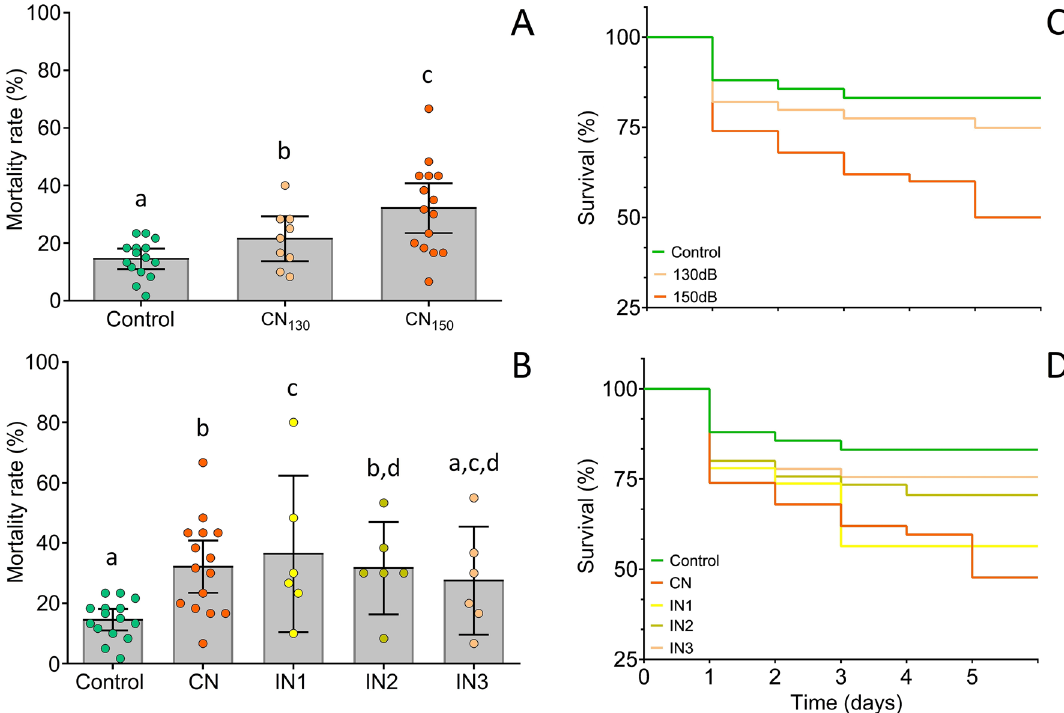
Figure 1. Comparison of mean mortality rate between treatment groups (larval zebrafish up to 5 days post fertilization) exposed to ( A ) continuous noise at different amplitudes (F (2, 38) = 8.71, p < 0.001) and ( B ) varying noise temporal patterns (F (4, 47) = 3.78, p = 0.005). Kaplan–Meier percentual survival plot of zebrafish larvae throughout the 5-days of chronic acoustic treatments of ( C ) increasing noise amplitudes and ( D ) varying temporal patterns. Control- silent conditions, CN- continous noise at either 130 (CN 130 ) or 150 dB re 1 μPa (CN 150 ), IN- intermittent regime with short (IN1), medium (IN2) and long noise segments (IN3). Error bars represent 95% confidence intervals. Different letters indicate statistically significant differences between specific groups based on post hoc